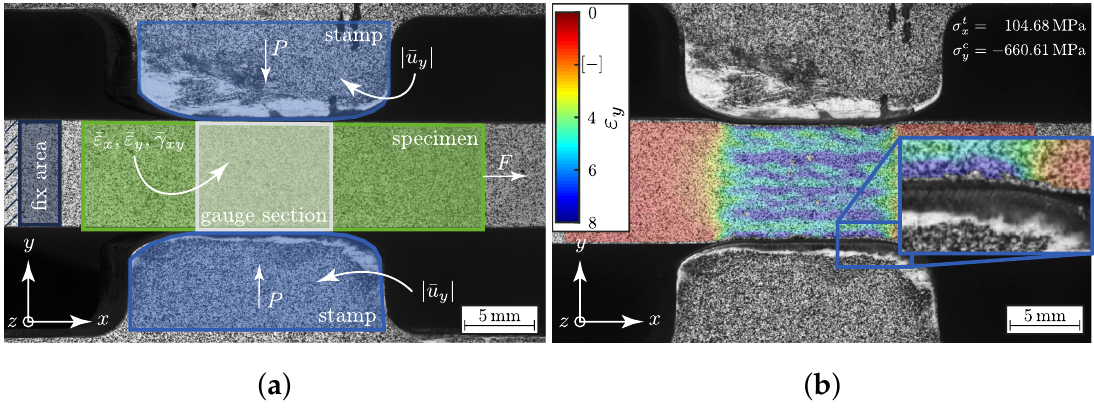
Figure 4. ( a ) Illustration and definition of evaluation areas of the 2D strain field measurement with DIC (A RAMIS R (cid:13) ); ( b ) exemplary illustration of the obtained ε y strain field at a prescribed load path of { ˜ σ } = 1 : 5 (Equation (2)) and magnification of the stamp indentation. L